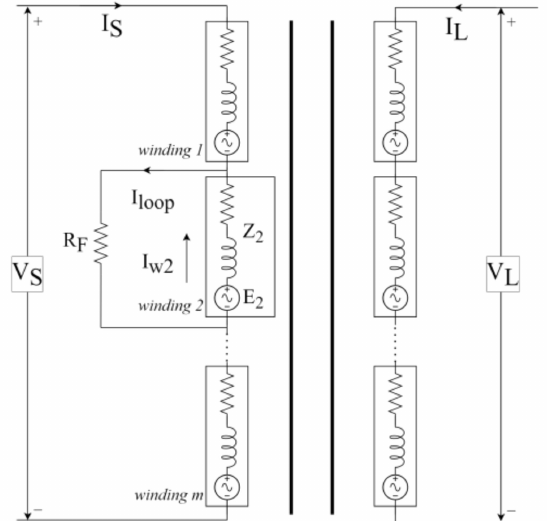
Figure 5. Equivalent circuit of transformer ITSC fault, with two turns windings